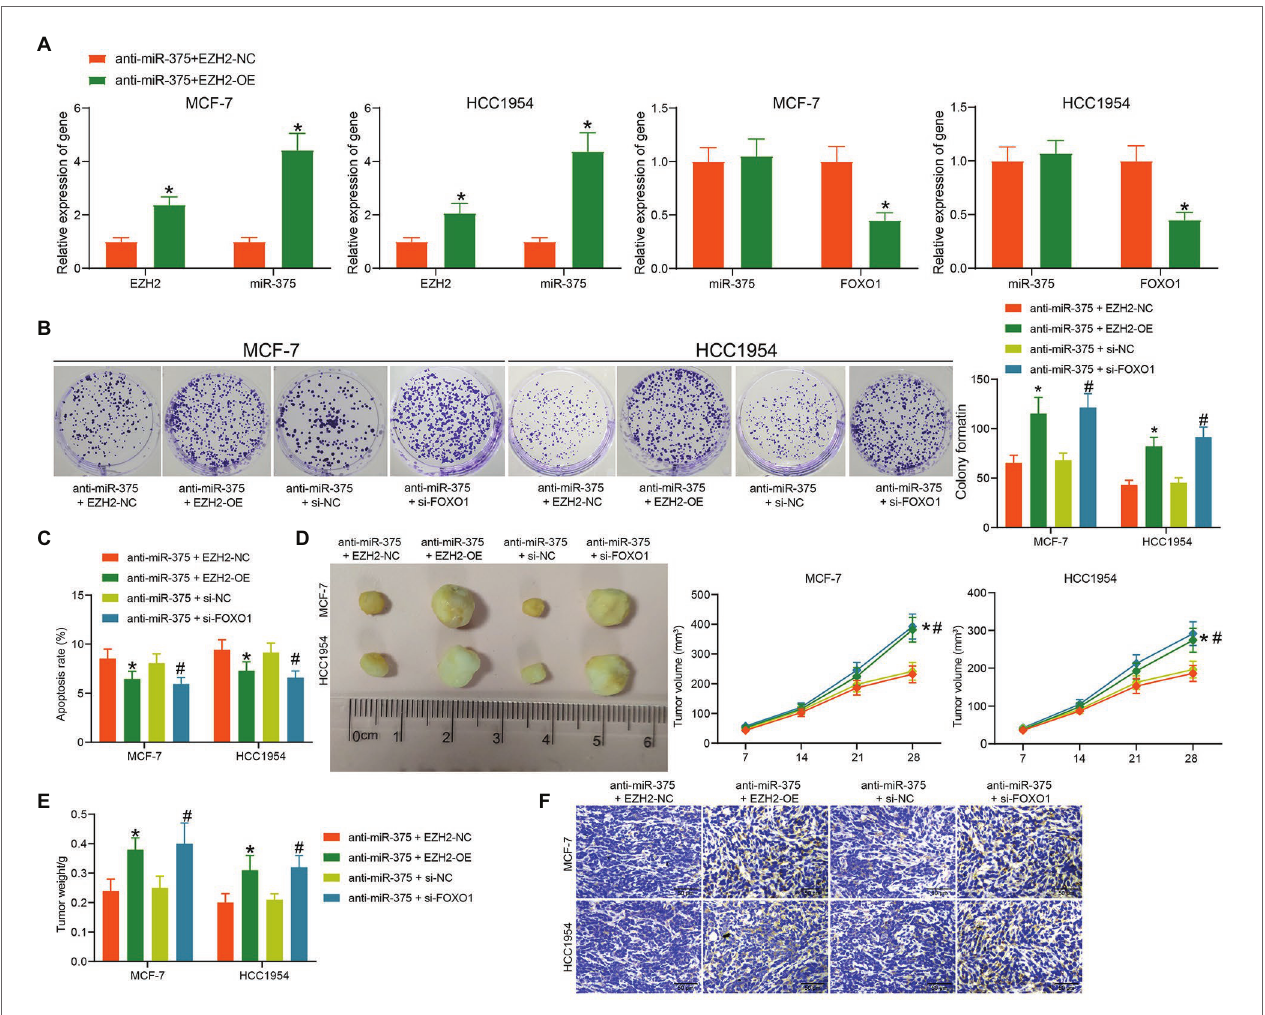
FIGURE 6 | Interactions among EZH2, miR-375, and FOXO1 in BC development. (A) mRNA expression of FOXO1 in cells after EZH2-OE or si-FOXO1 transfection determined by RT-qPCR (* # p < 0.05, two-way ANOVA); (B) proliferation of cells determined by colony formation assay (* # p < 0.05, two-way ANOVA); (C) apoptosis of cells determined by flow cytometry (* # p < 0.05, two-way ANOVA); (D,E) volume (D) and weight (E) of xenograft tumors in nude mice; (F) Ki-67 expression in the tumor sections determined by IHC staining. Data were presented as mean ± SD from three independent experiments. In animal models, n = 3 in each